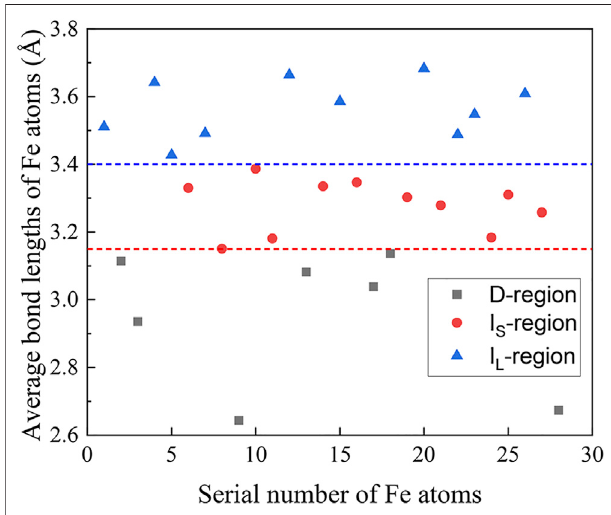
FIGURE 5 | Distribution of the average bond length of Fe atoms.